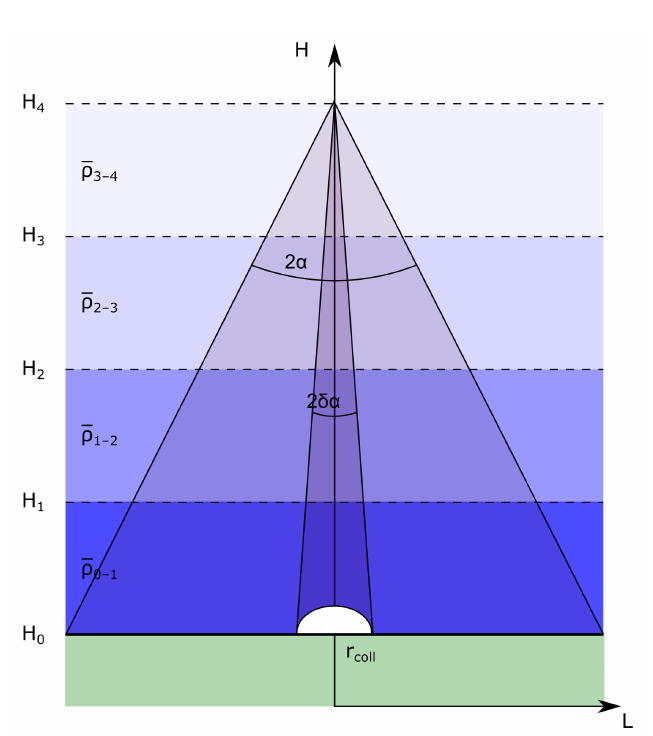
Figure 5. Schematic ( L , H ) diagram of a total TGF emission, inside a half-angle α = 40 ◦ , and of its related sub-half-angle δα , directly subtending the collecting area under analysis (here, the surface of the dome housing the Gamma-Flash detectors, with radius r coll = 63 cm). Radiation traveling from source to target crosses different atmospheric layers at different altitudes H , with different average densities ¯ ρ ( H ) (shaded regions), and undergoes different amounts of radiation-matter